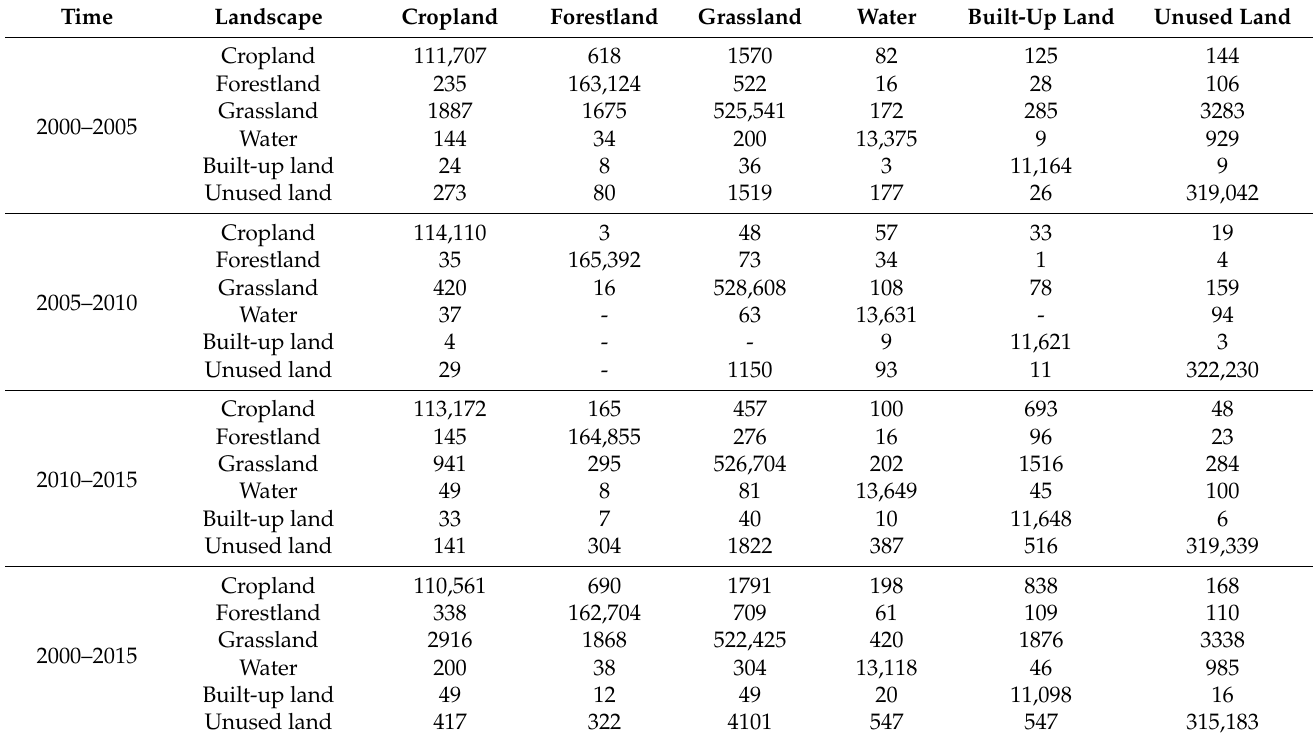
Figure 3. Landscape-type distribution map in Inner Mongolia from 2000 to 2015. Table 2. Landscape transfer matrix in Inner Mongolia from 2000 to 2015 (km 2